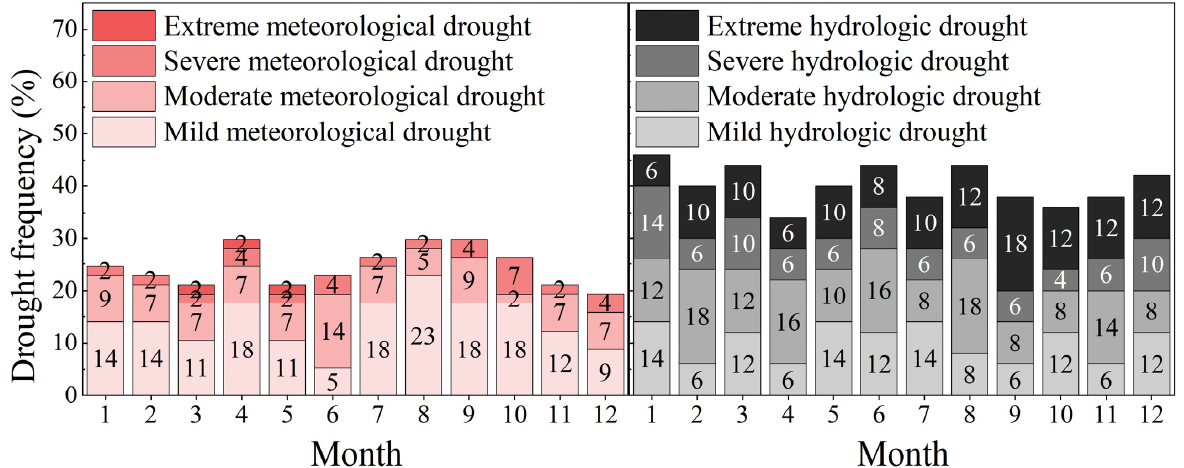
Figure 5. Monthly variation of drought frequency in the YJB from 1960 to